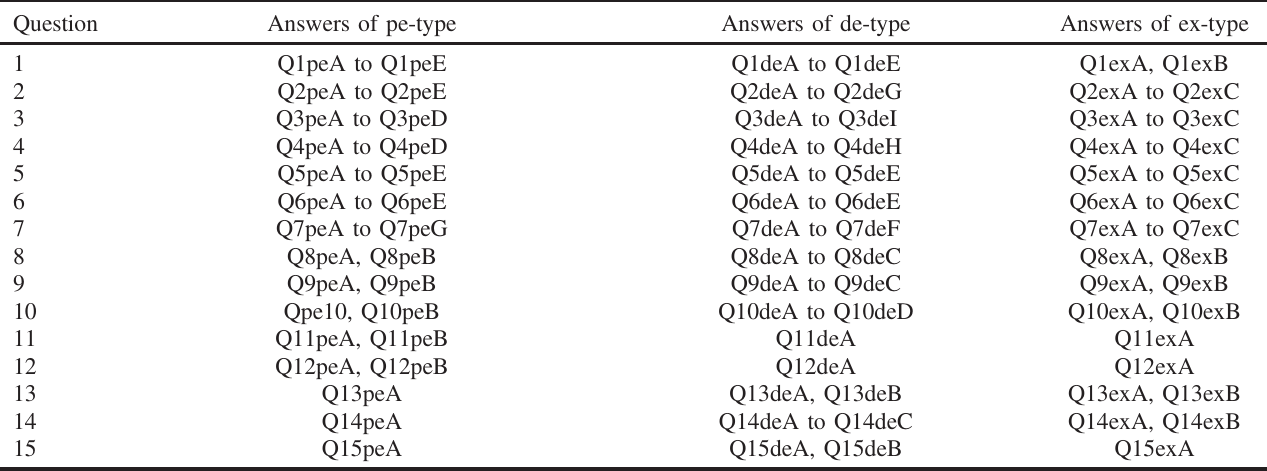
TABLE II. Classification of answers to the questionnaire within the three typologies of Table I. Question Answers of pe-type Answers of